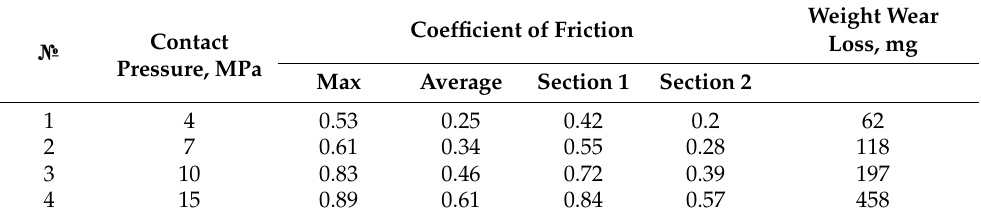
Coefficient of Friction